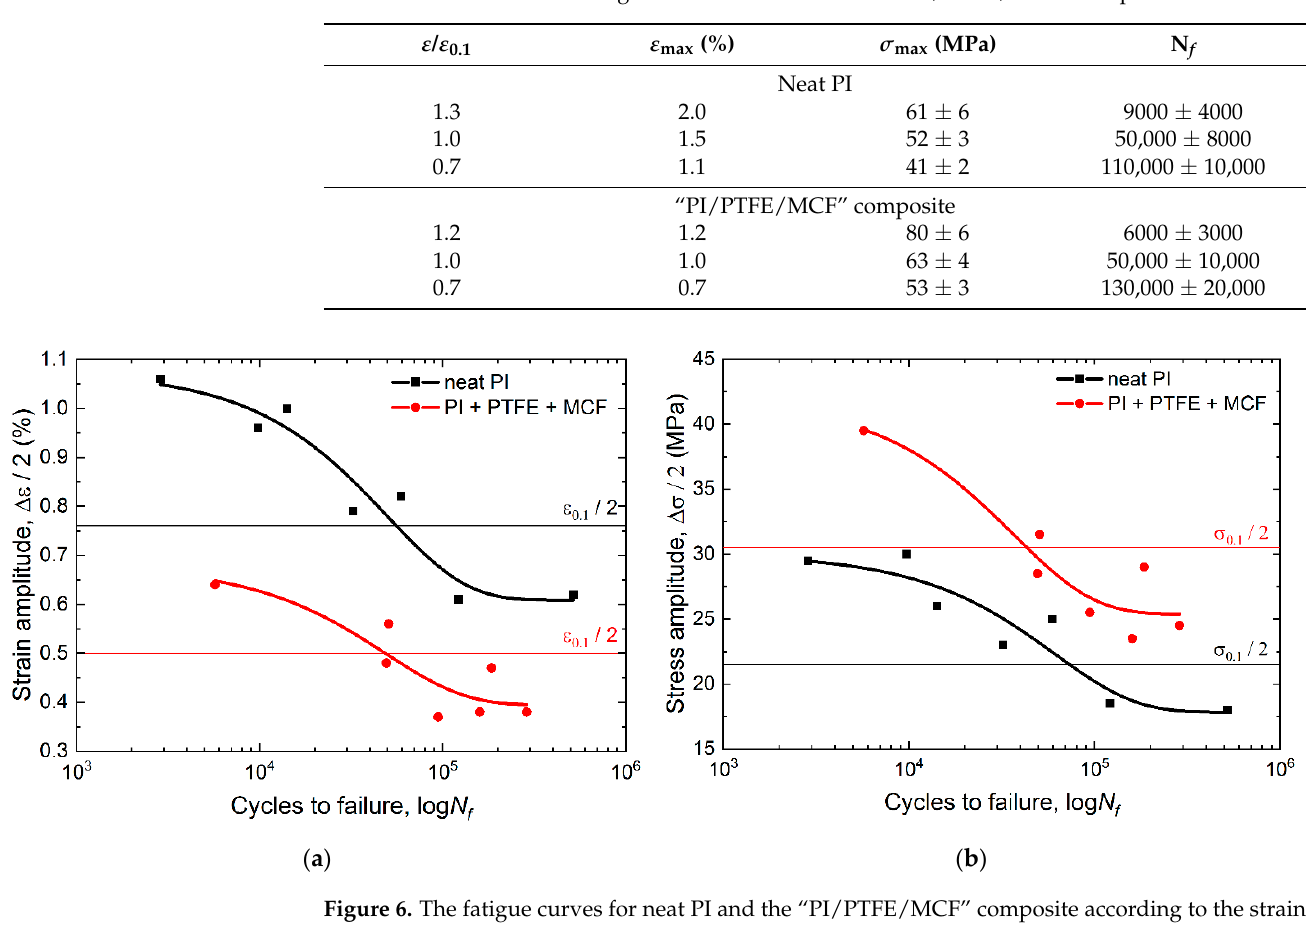
Figure 6. The fatigue curves for neat PI and the “PI/PTFE/MCF” composite according to the strain ( a ) and stress ( b ) amplitudes. ( a ) and stress ( b )